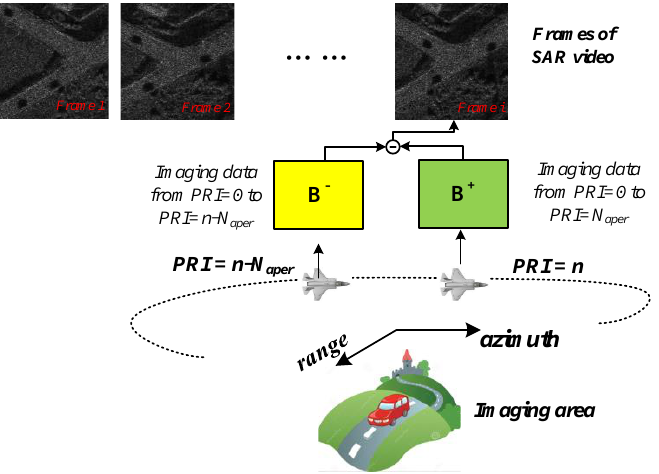
Figure 4. The diagram of video-SAR back-projection algorithm. B + ( B − ) is a physical memory storage used to temporarily store imaging data from pulse repetition indices (PRI) = 0 to PRI = n-Naper (PRI =